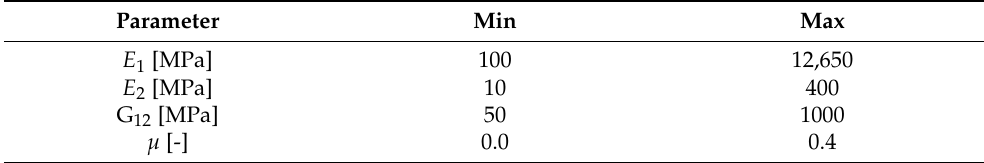
Table 1. Range of parameter values E 1 , E 2 , G 12 and 𝜇 .